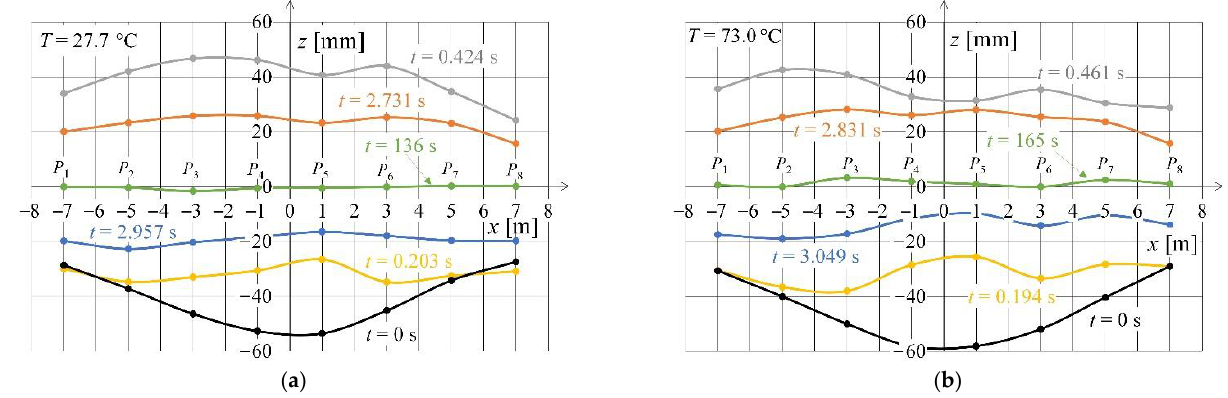
Figure 15. Spatial distribution of light points for selected recording times and contact wire temperature equal to: ( a ) 27.2 °C; ( b ) 73.0 °C.